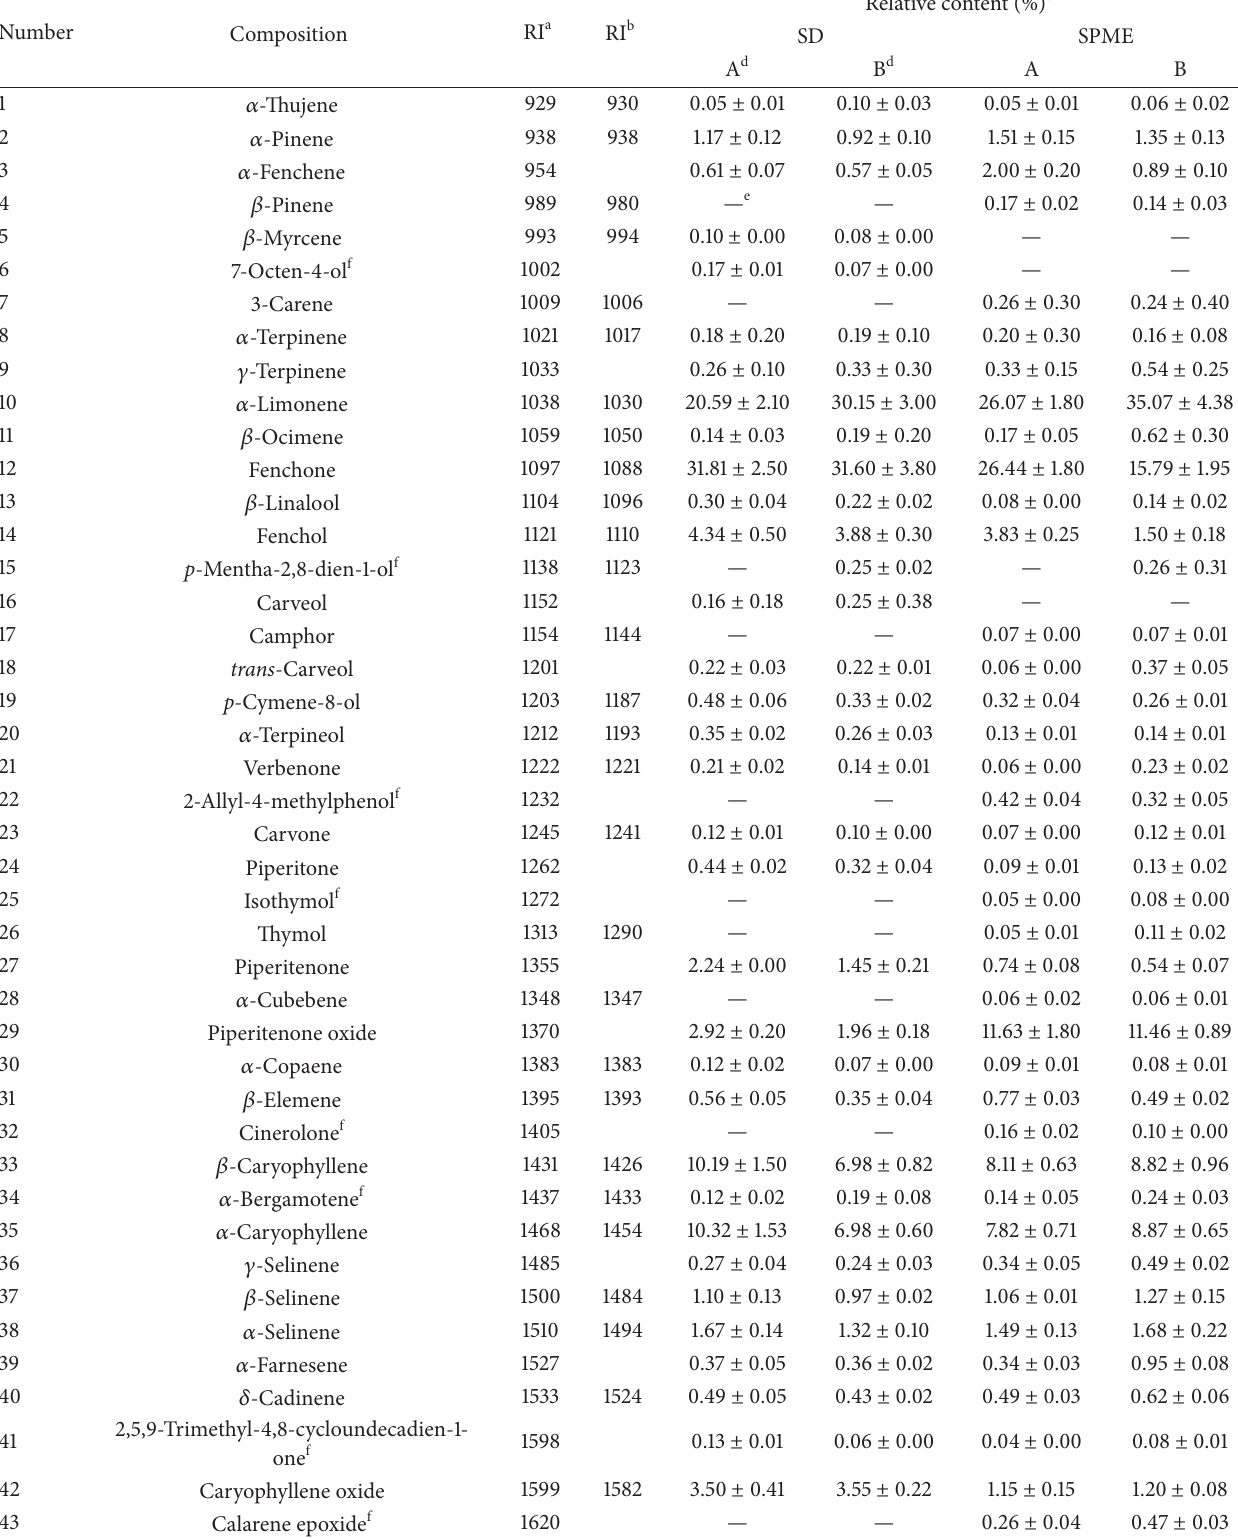
Table 1: The chemical compositions of volatile components from A. indianum (Lour.) Merr. obtained by SD and HS-SPME from two regions of